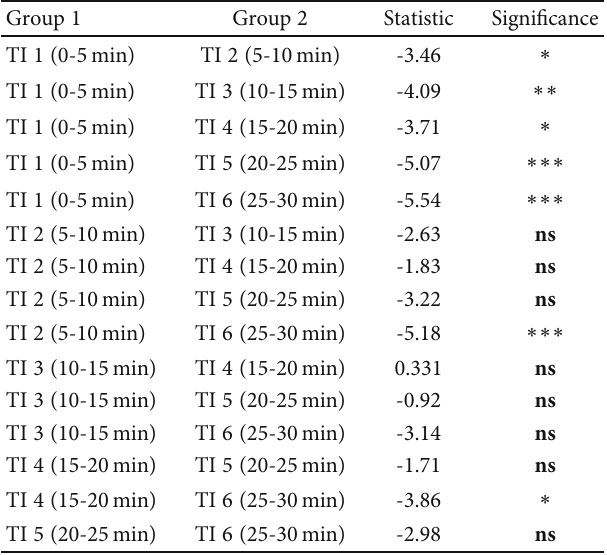
Note: signi fi cant e ff ects are marked by asterisks and bold text. ∗∗∗ p < 0 : 001 , ∗∗ p < 0 : 01 , and ∗ p < 0 : 05 . p values are Bonferroni corrected. TI denotes the time interval, e.g., TI 1 denotes the fi rst time interval: